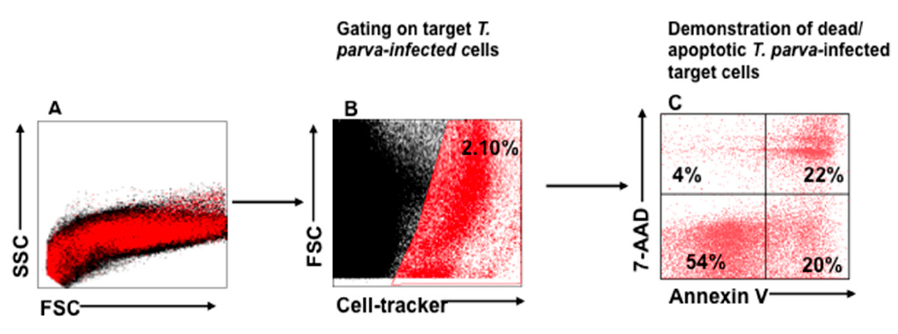
Figure 2. Gating strategy used to isolate labeled T. parva -infected target cells for analysis of CTL-mediated killing. ( A ) Representative mixture of CTLs and autologous, irradiated T. parva -infected cells (target cells) labeled with CellTracker Deep Red, annexin V, and 7-AAD after co-incubation for 6 h, displayed in SSC vs. FSC. ( B ) Selective gate used to isolate labeled cells for analysis displayed in FSC vs. CellTracker. ( C ) Gated infected cells displayed in 7 AAD vs. annexin V to show the proportion of infected cells undergoing apoptosis. The cells in the lower left quadrant show the proportion of live target cells remaining after incubation with CTLs for 6 h. The lower right quadrant shows the proportion of cells undergoing the initial stages of apoptosis (annexin V+/7AAD-). The upper right quadrant shows the proportion of target cells in late stages of apoptosis (annexin V+/7AAD+), and the upper left quadrant shows the proportion of target cells undergoing necrosis/non-apoptotic mechanisms of death (annexin V-/7AAD+).